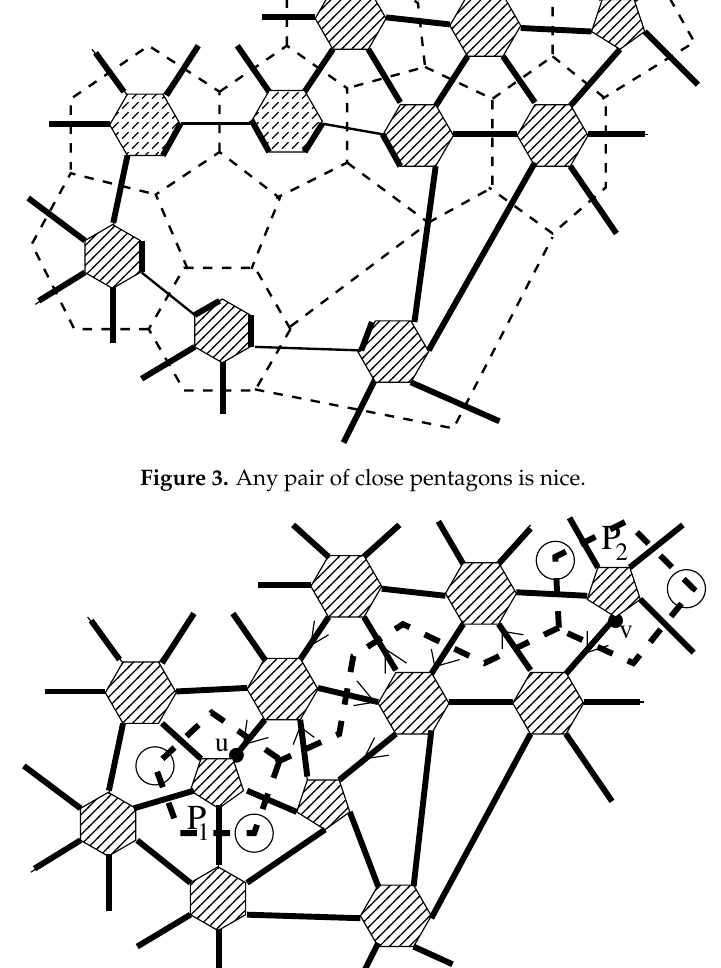
Figure 4. An M -alternating odd path connecting two remote